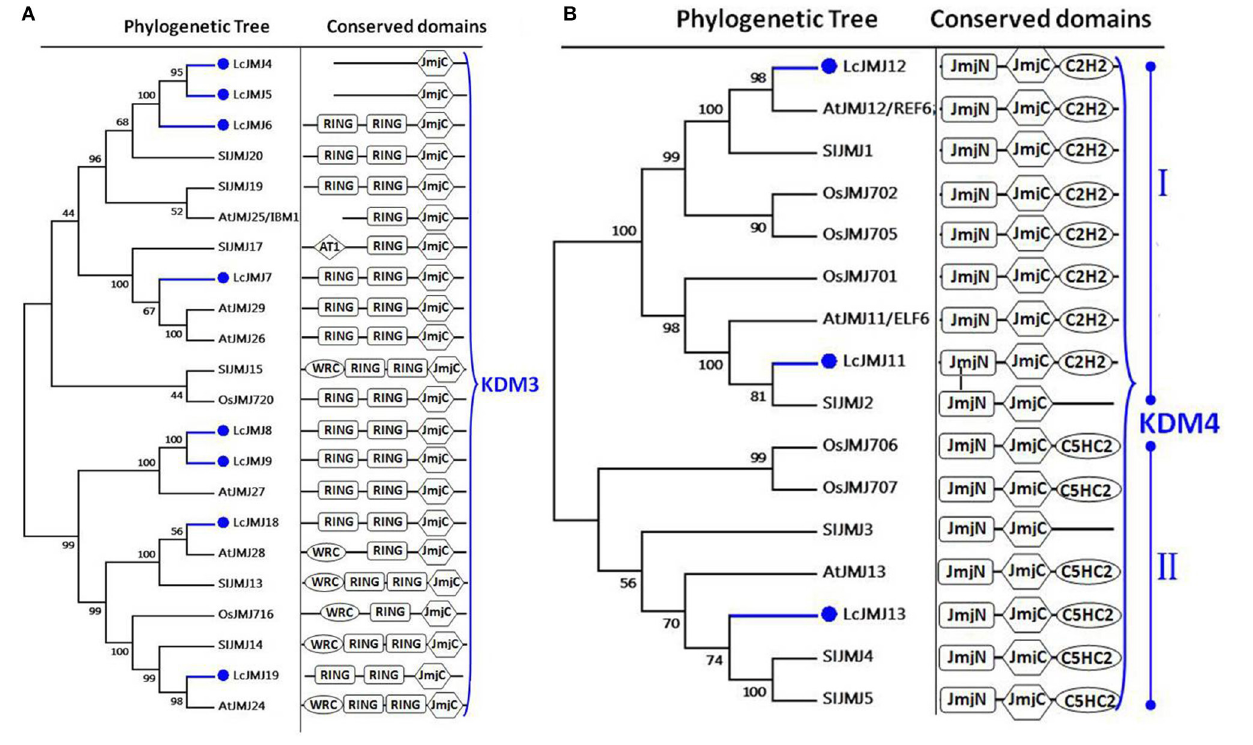
Frontiers in Plant Science |